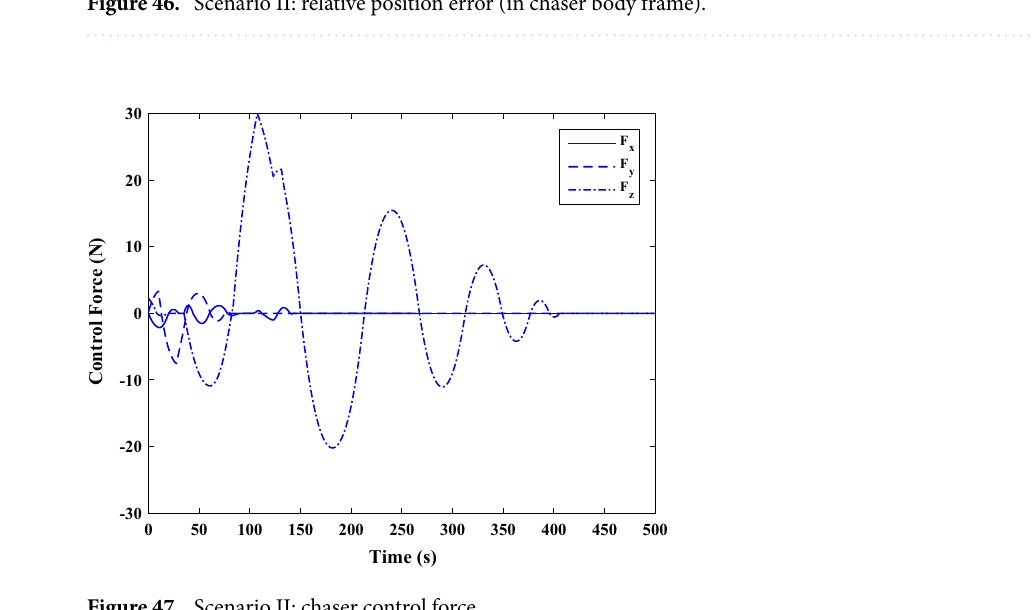
Figure 47. Scenario II: chaser control force.